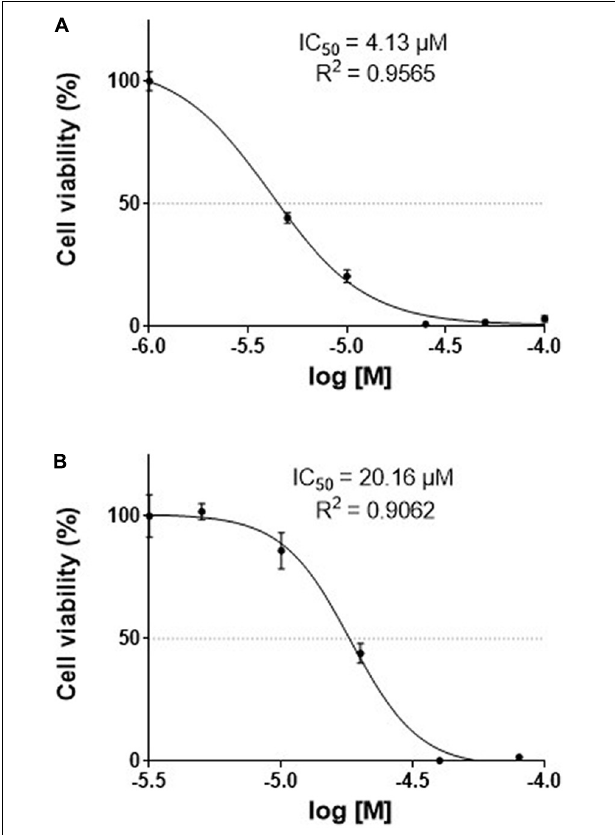
FIGURE 2 | Effects of TGM4 on the proliferation of Mia-PaCa-2 (A) and PANC-1 (B) human pancreatic cell lines. Mia-PaCa-2 and PANC-1 were exposed to increasing doses (50–1000 µ M) of TGM4 for 72 h, and cell viability was determined using the XTT method ( n = 12). The IC 50 values for TGM4 in Mia-PaCa-2 and PANC-1 were 20.16 and 4.13 µ M, respectively.